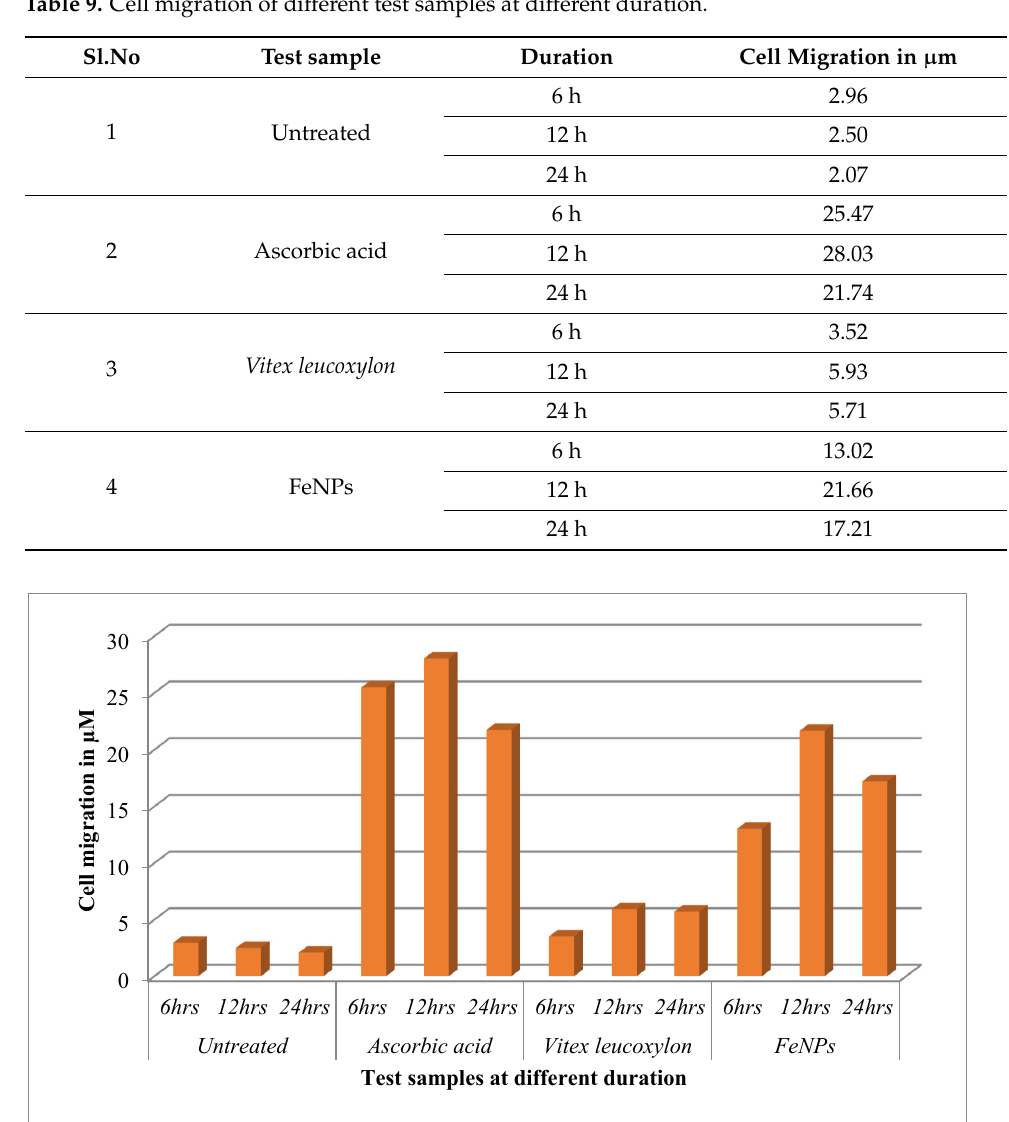
Figure 16. Cell migration of V. leucoxylon extract and its synthesized FeNPs. Table 10. Percentage of wound closure of different test samples.